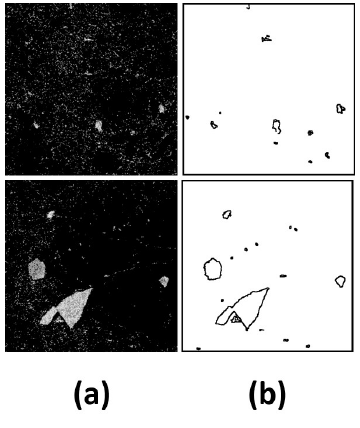
Figure 7. (a) SAR images of the areas referred to the Sector I in the map of Figure 6. (b) Edge detection result of applying the Adaptive Canny